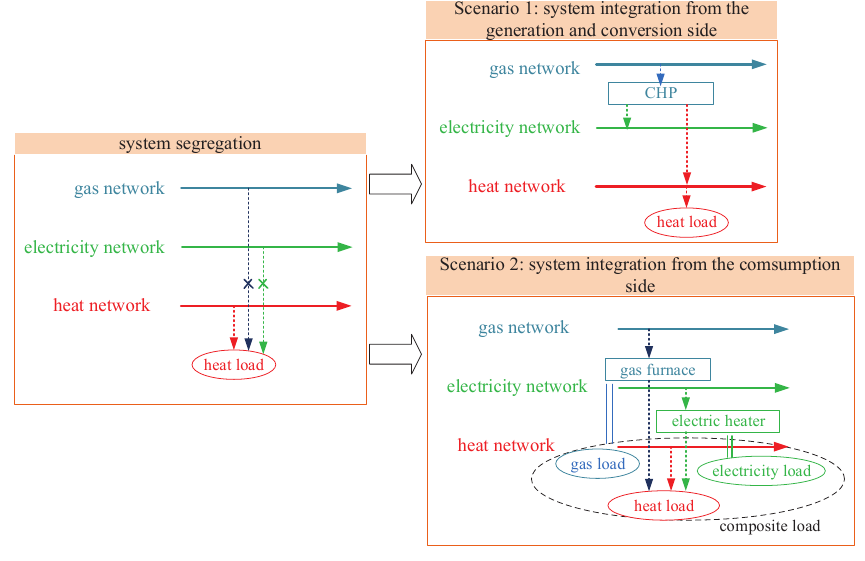
Figure 1. Schematic diagram of two-area classic